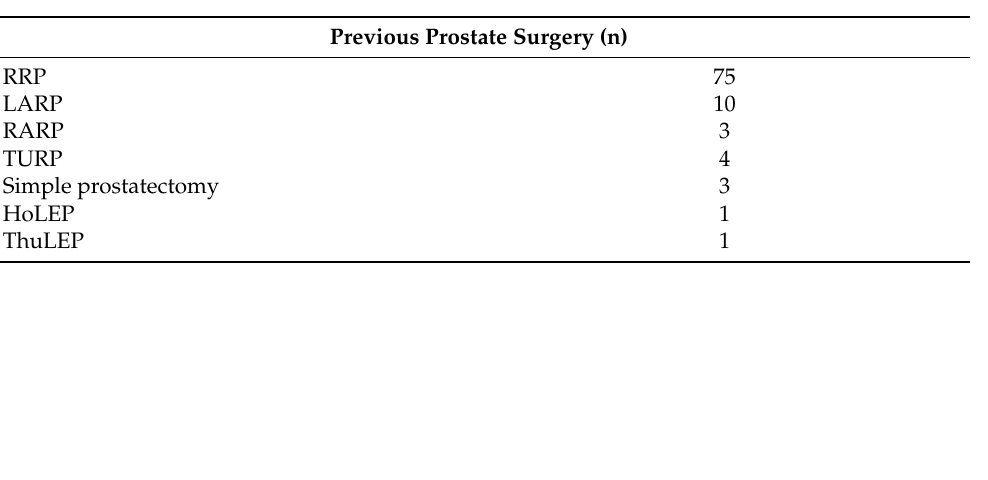
Table 1. Baseline